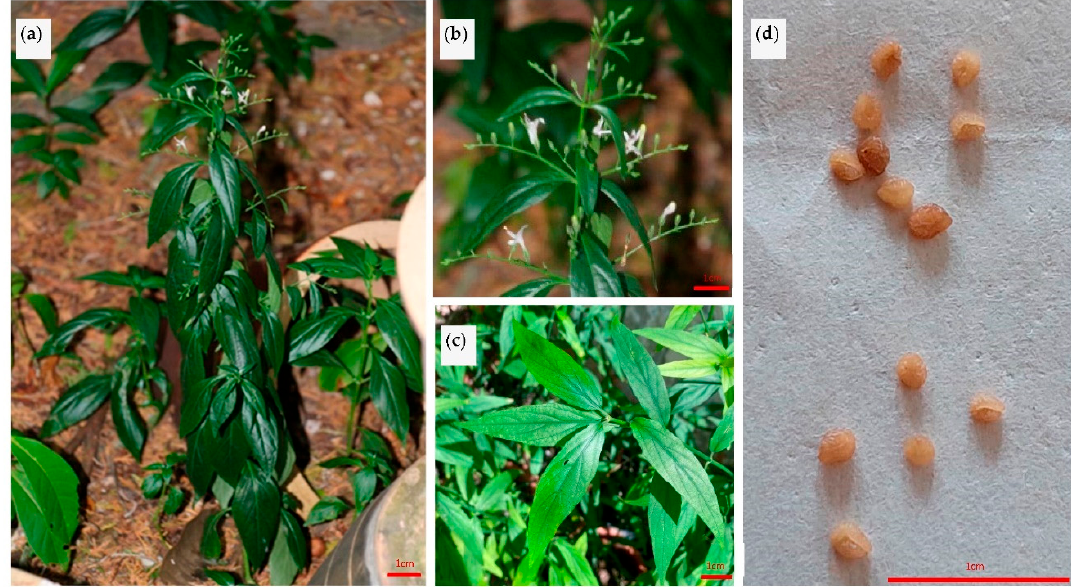
Figure 1. Images of Andrographis paniculata : ( a ) whole plants, ( b ) flowers, ( c ) leaves, and ( d ) seed. Bar = 1 cm.